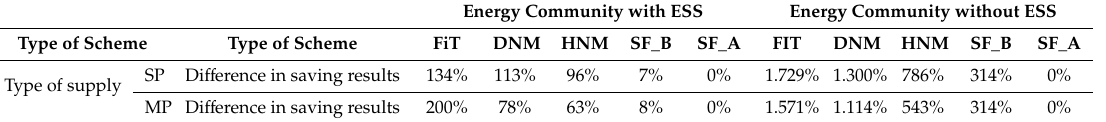
Table 7. Di ff erences in saving results under di ff erent regulatory schemes